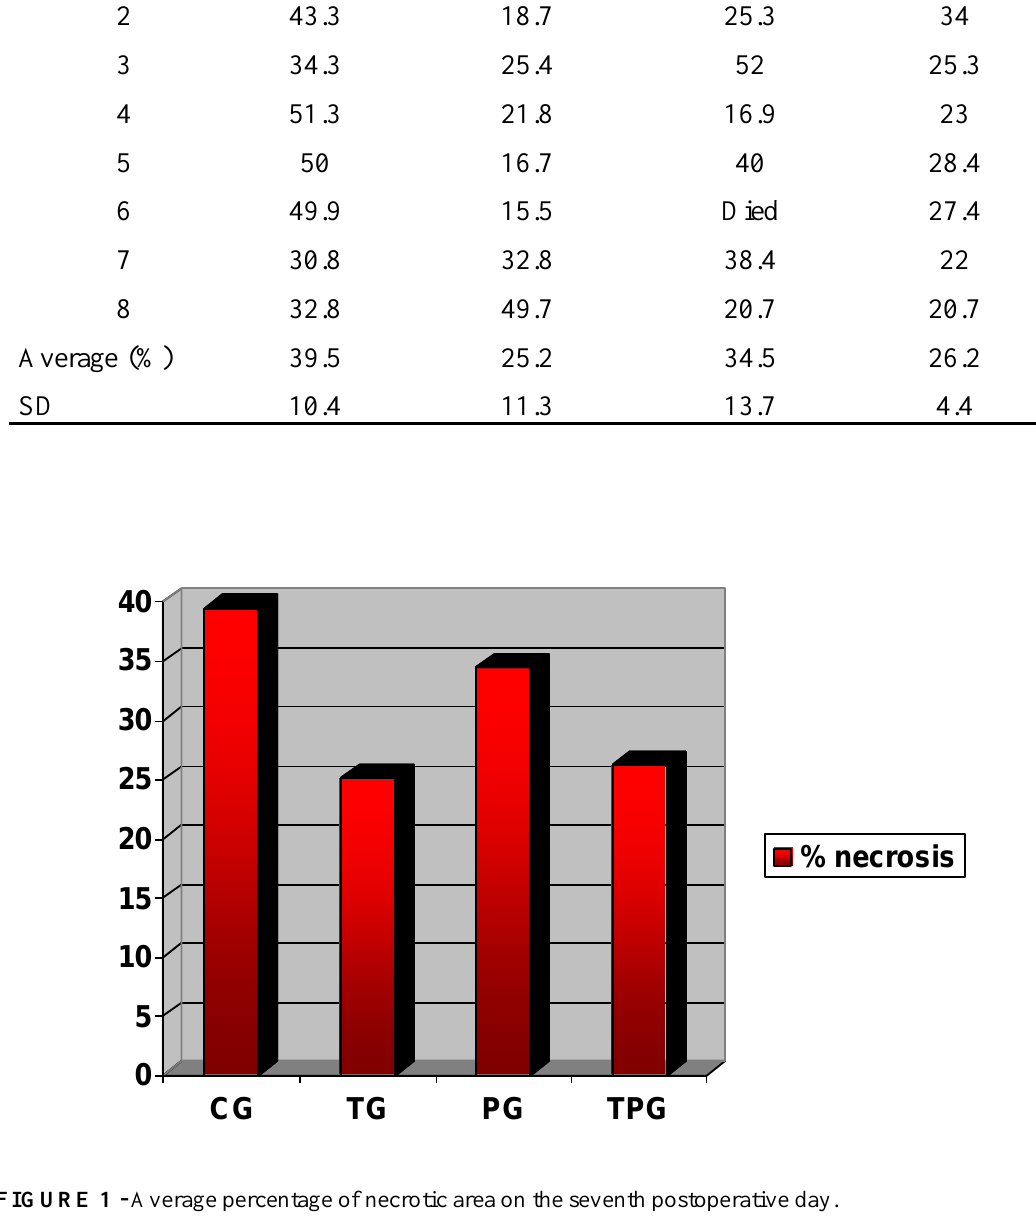
MDA serum concentrations in CG (control) ranged between 1634 ng/ml and 4716 ng/ml (average 3395 ng/ml); in TG (Terazosin) ranged between 2472 ng/ml and 7910 ng/ml (average 3774 ng/ml); in PG (Propranolol) ranged between 1702